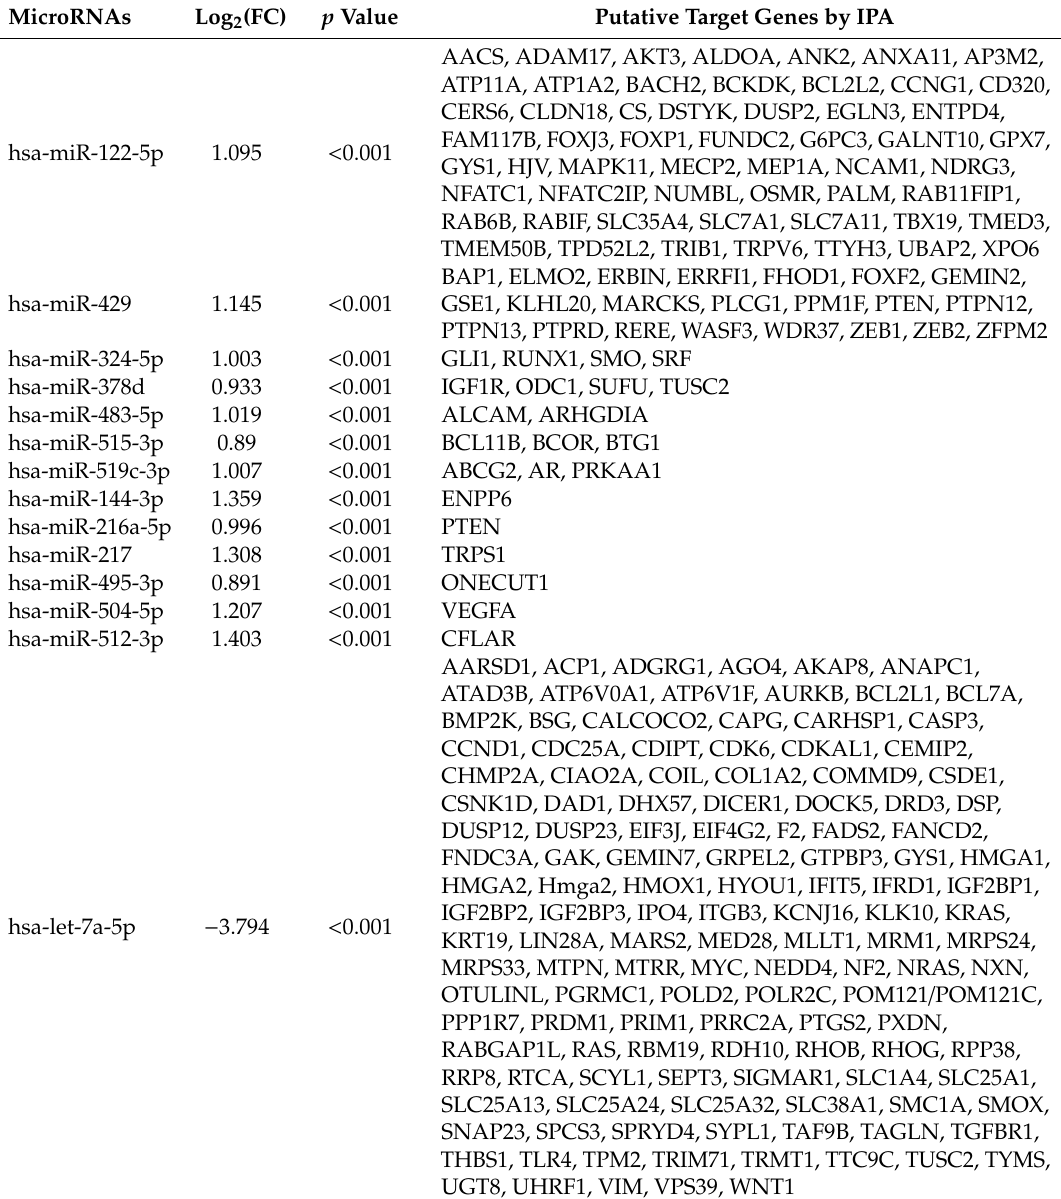
Table 2. Changed miRNAs and target genes by ingenuity pathway analysis